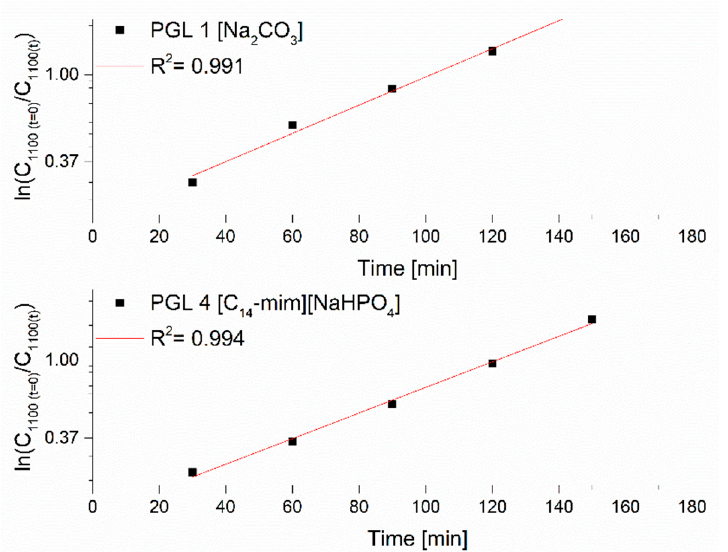
Figure 6. Consistent with Equation (4): Relationship of the absorbance of the C–O–C band at 1100 cm − 1 as a function of time for the oligomerization of PGL 1 versus Na 2 CO 3 and PGL 4 versus [C 14 -mim] [NaHPO 4 ].